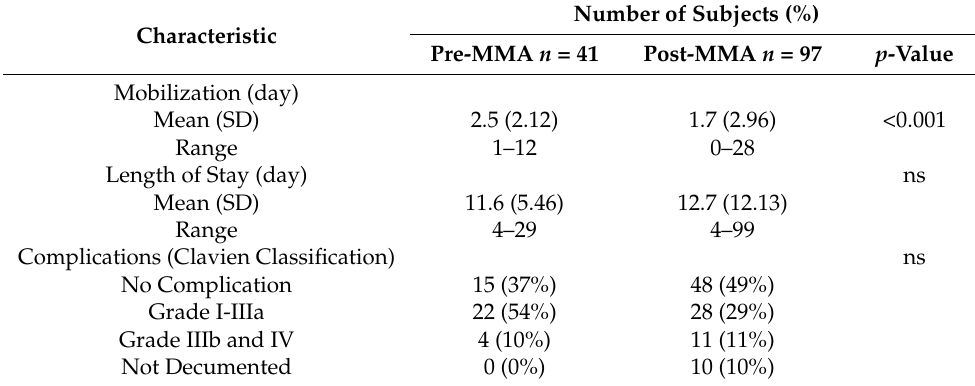
Table 2. Postoperative